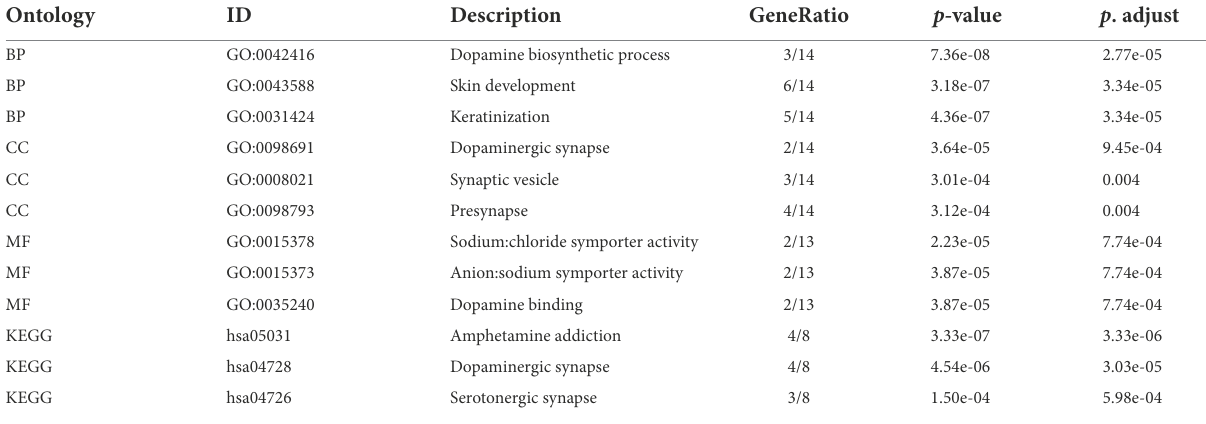
TABLE 5 Functional enrichment analysis of hub genes.